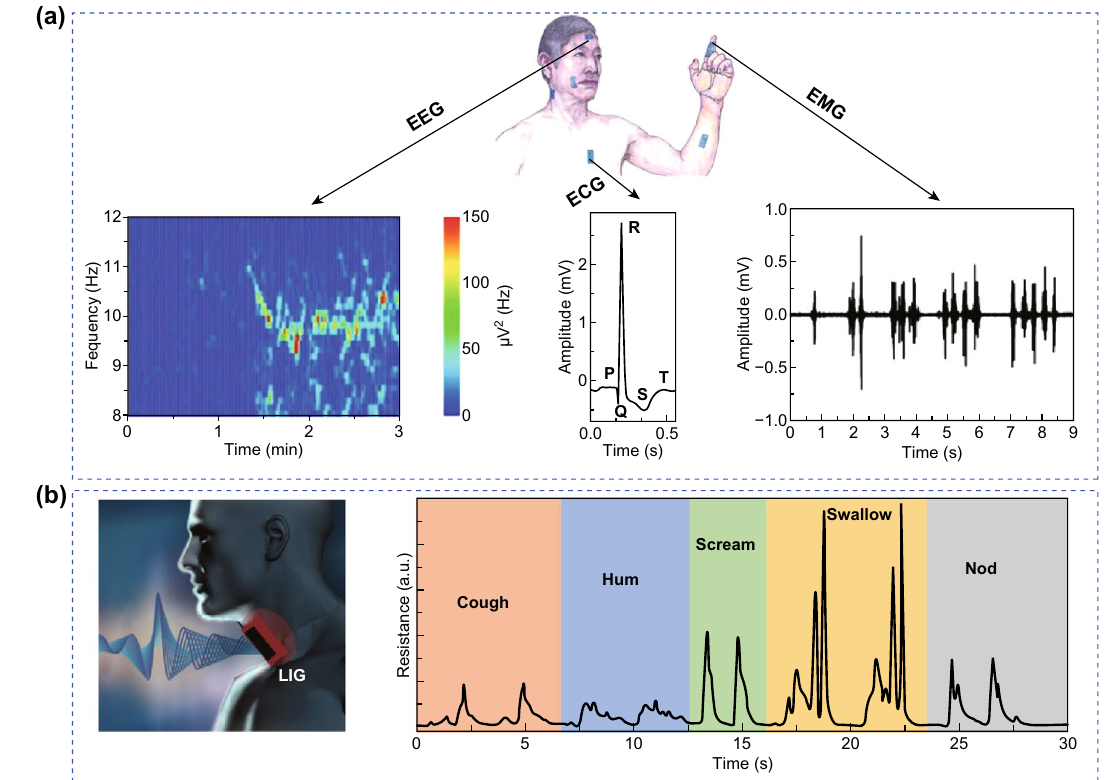
Fig. 8 a EEG, ECG, and EMG measurements. Adapted with the permission from Ref. [72], Copyright 2018 WILEY-VCH Verlag GmbH & Co. KGaA, Weinheim. b LIG-based artificial throat with sound-sensing. Adapted with the permission from Ref. [7], Copyright 2017 Springer